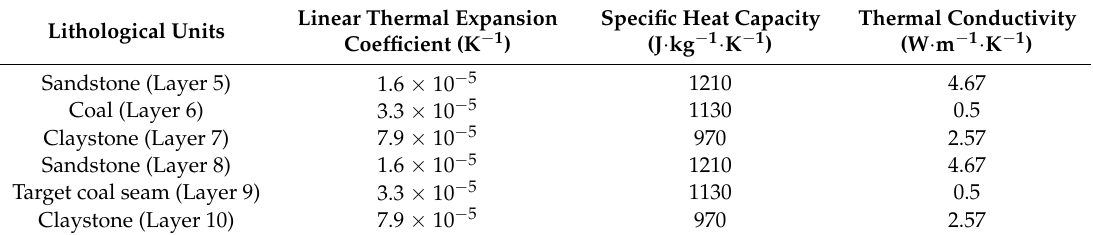
Table 2. Thermal parameters applied for Layers 5–10 in all simulation runs (from Somerton